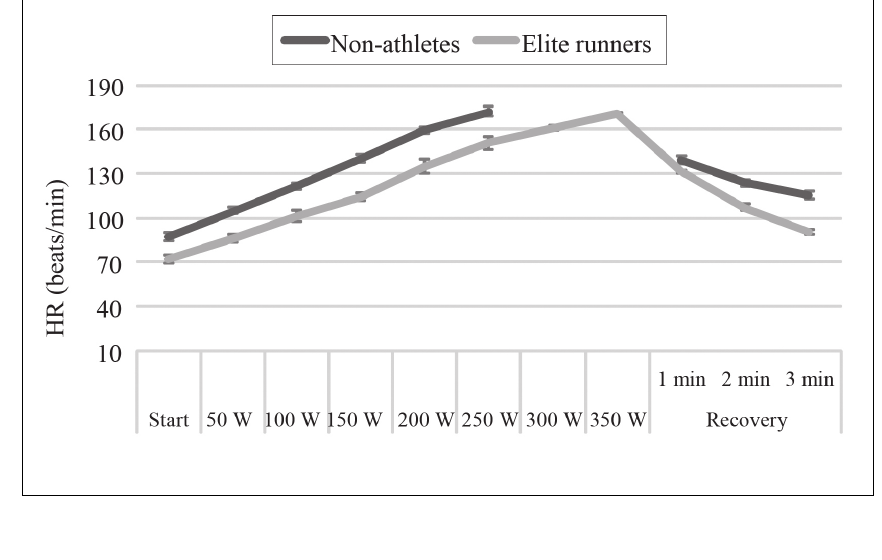
Figure 2. ST-segment depression changes in male elite runners and non-athletes during the performance of graded exercise tests to maximal